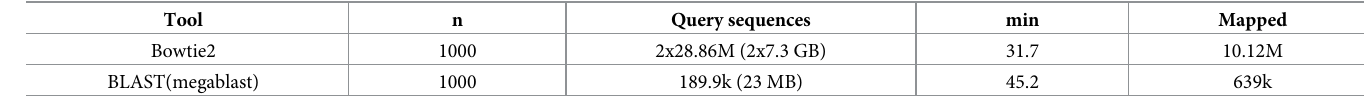
Table 5. Aligning sequences to compressed human pan-genome index of size n genomes.